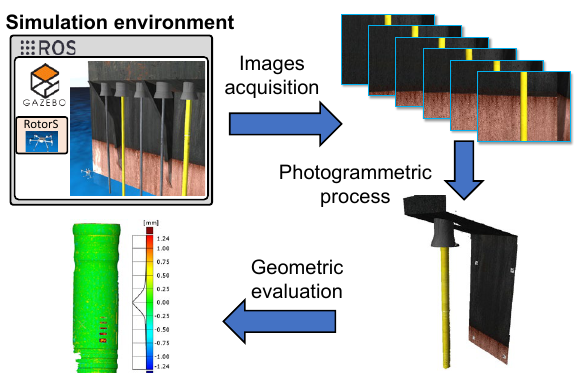
Figure 2. Evaluation process flow chart. Simulated images are processed and it is evaluated the resulted 3D